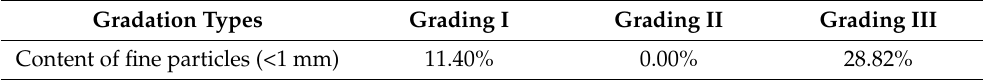
Table 2. Fine particle content of accumulation.